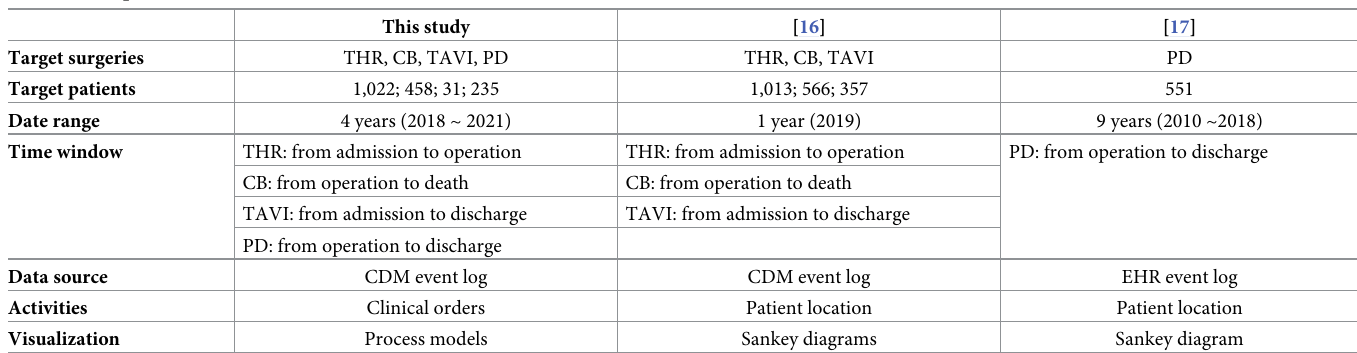
Table 8. Comparison with other